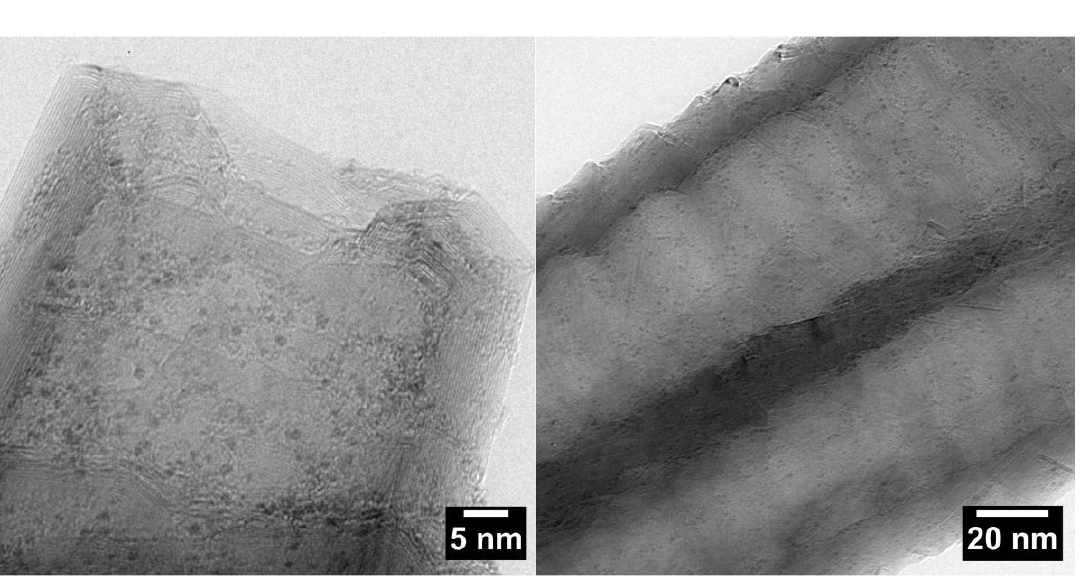
Figure 2. Representative TEM micrograph of the Ru/CNFs catalyst.